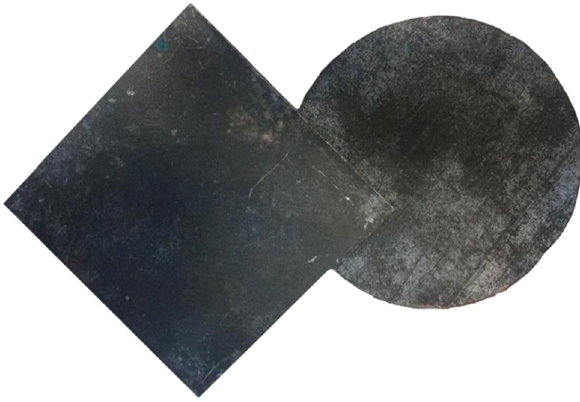
Figure 3: Tungsten used in the